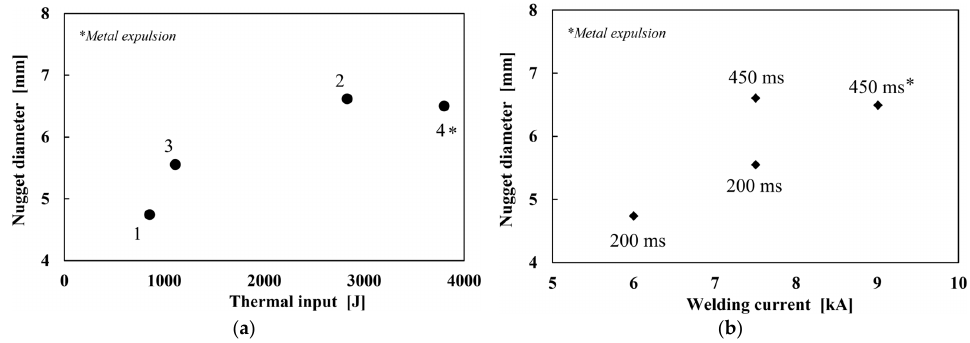
Figure 5. Average nugget diameter of the spot welds: influence of ( a ) the thermal input by Joule effect and ( b ) welding current and time for the different welding conditions.